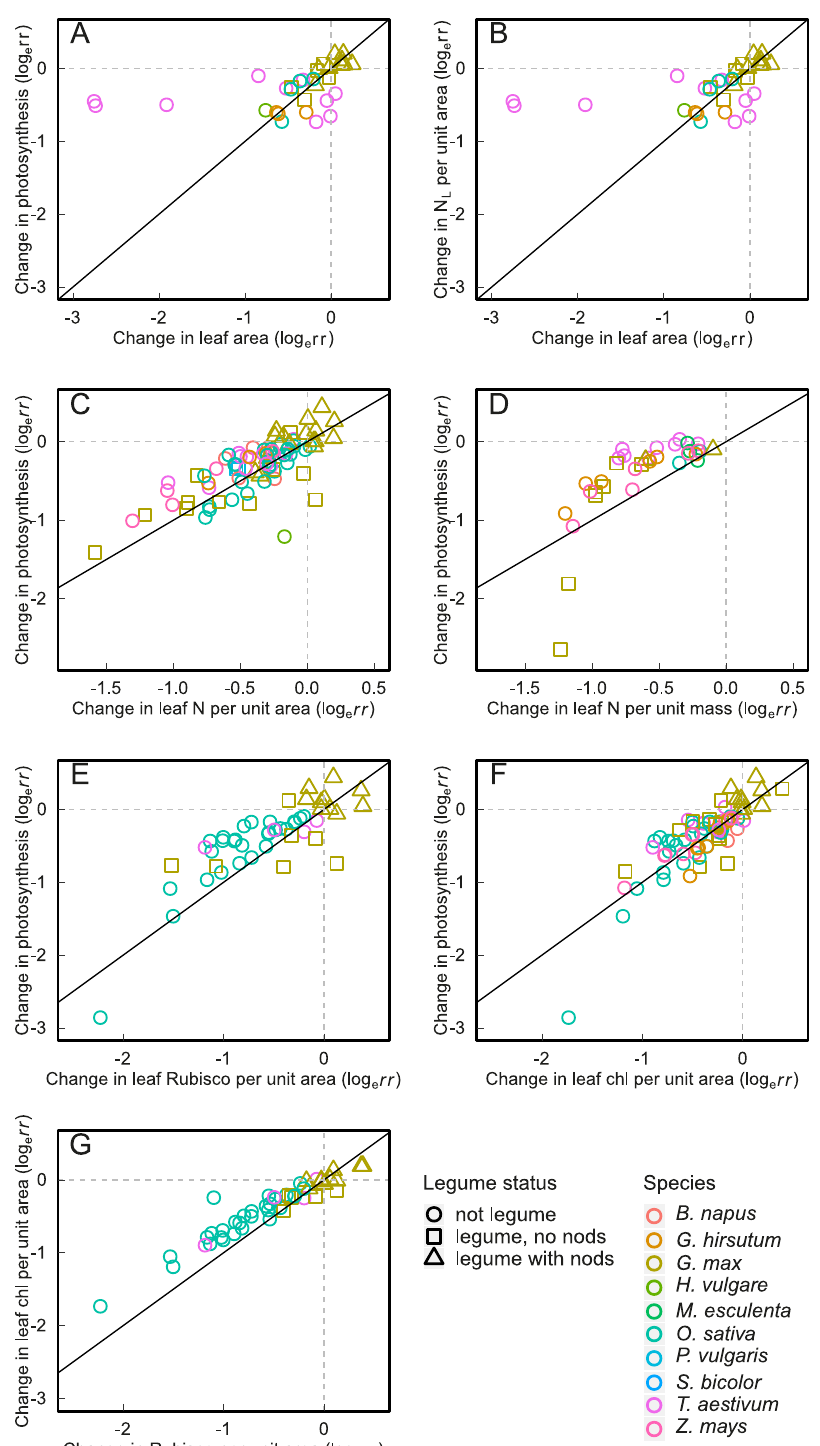
Fig 5. Correlation in the response of various leaf-level variables to N limitation. (a) photosynthetic versus leaf area responses, (b) leaf nitrogen (N L ) per unit area versus leaf area responses, (c) photosynthetic versus N L per unit area response, (d) photosynthetic versus N L per unit mass response, (e) photosynthetic versus Rubisco content response, (f) photosynthetic versus chlorophyll response, (g) chlorophyll versus Rubisco response. Black line represents a 1:1 relationship. Each dot represents one experiment in which both responses were measured. Correlation coefficients: